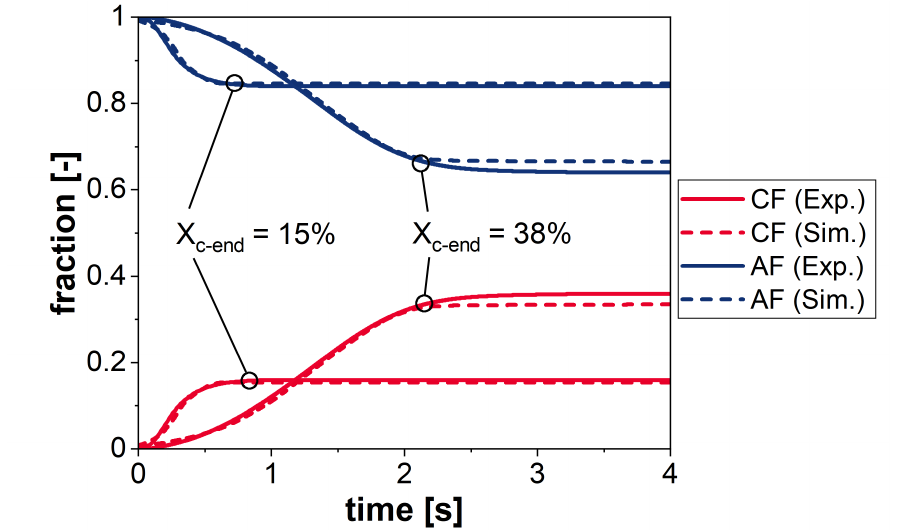
Figure 6. Comparison of the temporal evolution of the crystalline phase (CF) and the amorphous fraction (AF) between simulation and experiment for two different final degrees of crystallization. The phases MAF, MF, and RAF were combined to give the amorphous fraction